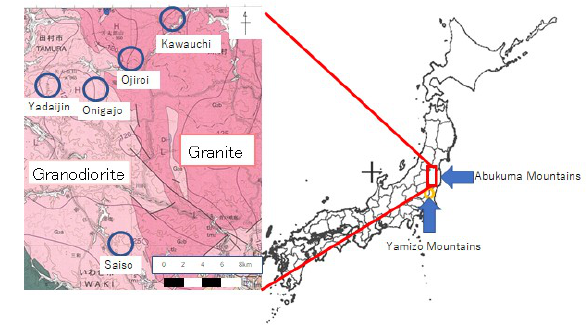
Figure 1 . Index map of studied